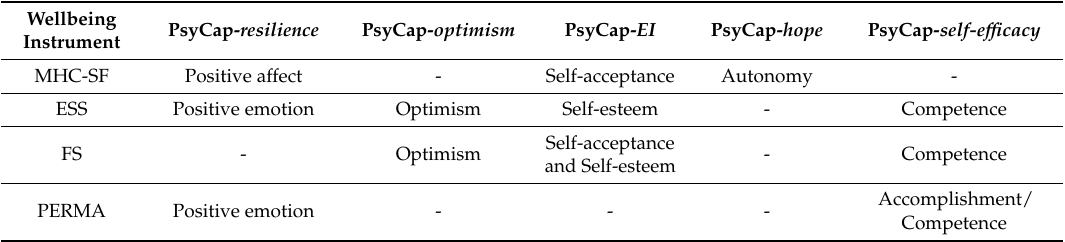
Table 2. Wellbeing elements antecedent to